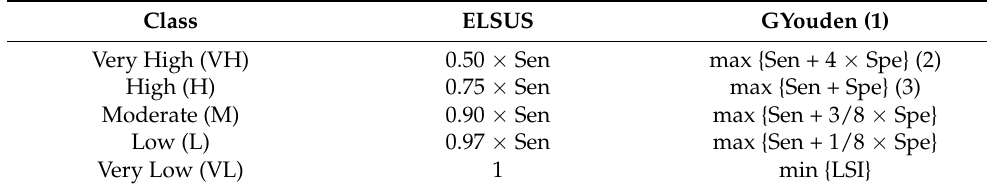
Table 7. Inferior class limits for ELSUS and